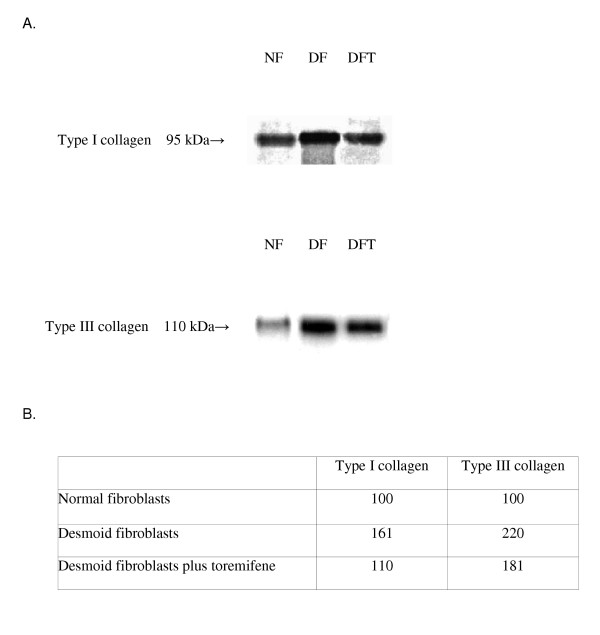
Western blot analysis of type I and III collagen secreted into the medium by normal and desmoid fibroblasts. Panel A. The samples are as follow: NF normal fibroblasts; DF desmoid fibroblasts; DFT desmoid fibroblasts plus toremifene. Similar results were obtained in four separate experiments. Panel B. The absolute counts, obtained by densitometric analysis, were converted to percentages assuming the level of normal fibroblasts as 100%.